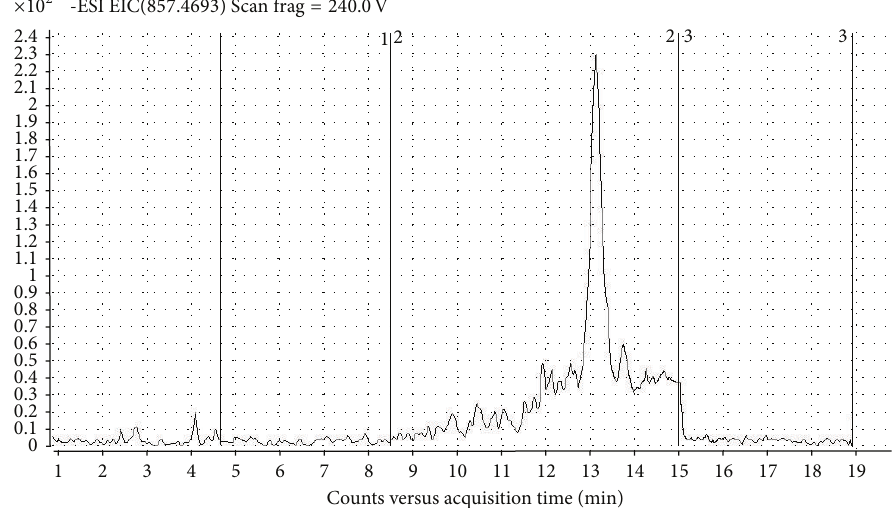
Figure 3: Selected ion monitoring HPLC-MS chromatogram of